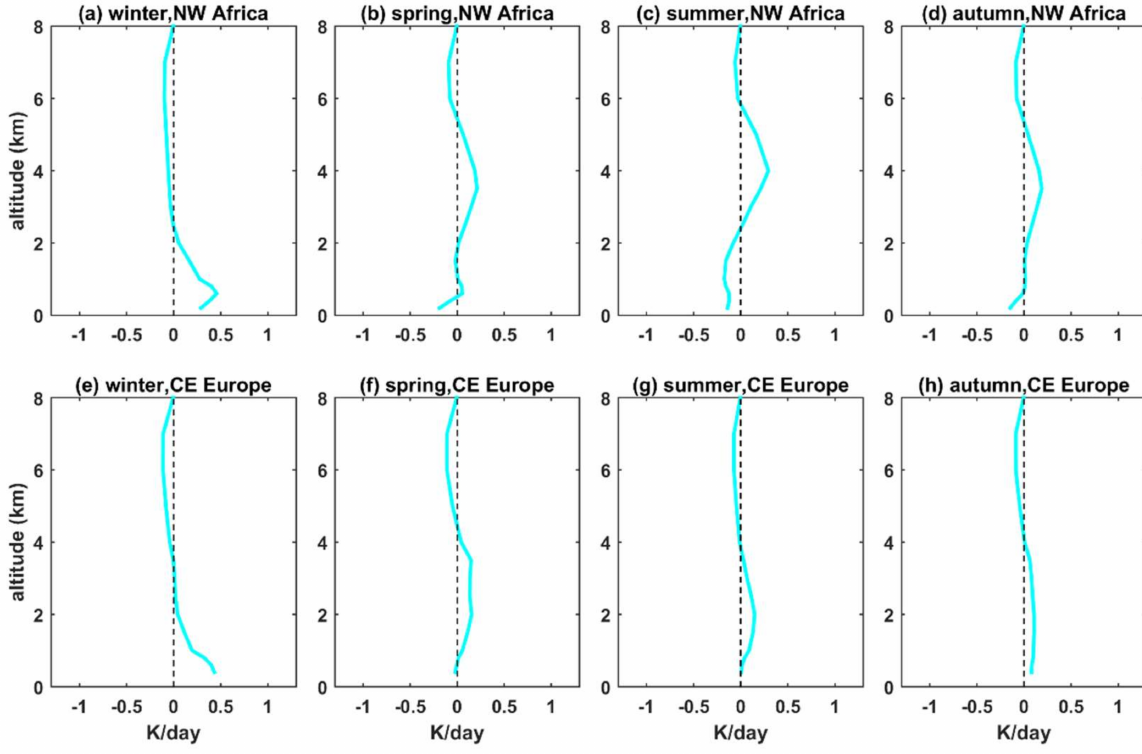
Figure A15. Same as Figure 10, but for SZA = 80 ◦ instead of SZA = 60 ◦